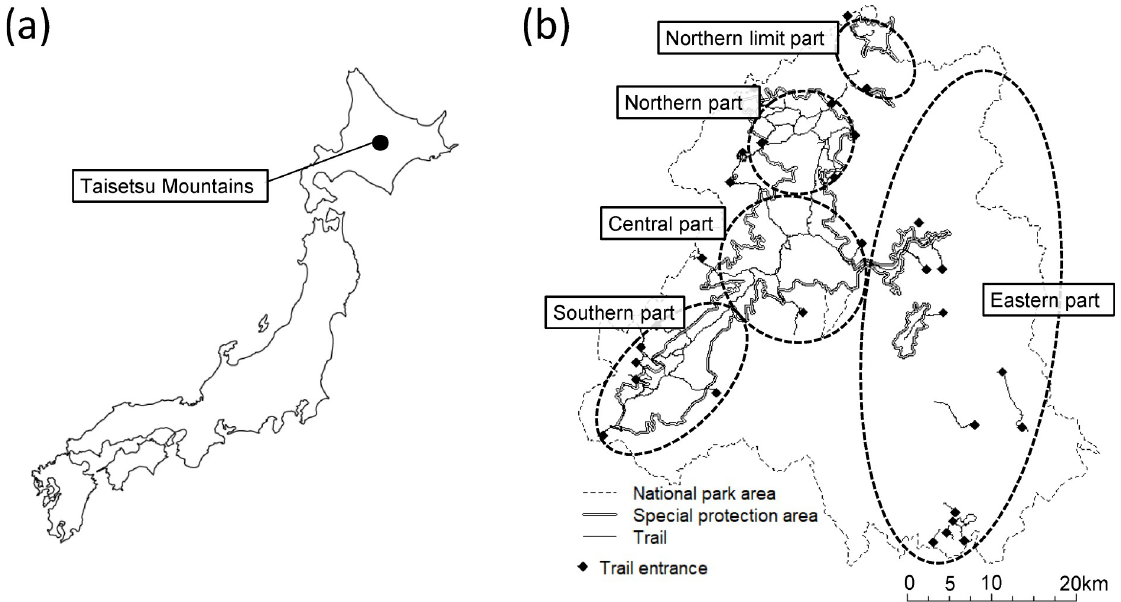
Fig 2. Study site. (a) The position of the Taisetsu Mountains and (b) the national park area. The national park area was drawn based on information provided by the Ministry of Land, Infrastructure, Transport and Tourism [14], and the trails were drawn based on information provided by the Ministory of the Environment [15] under a CC BY license with